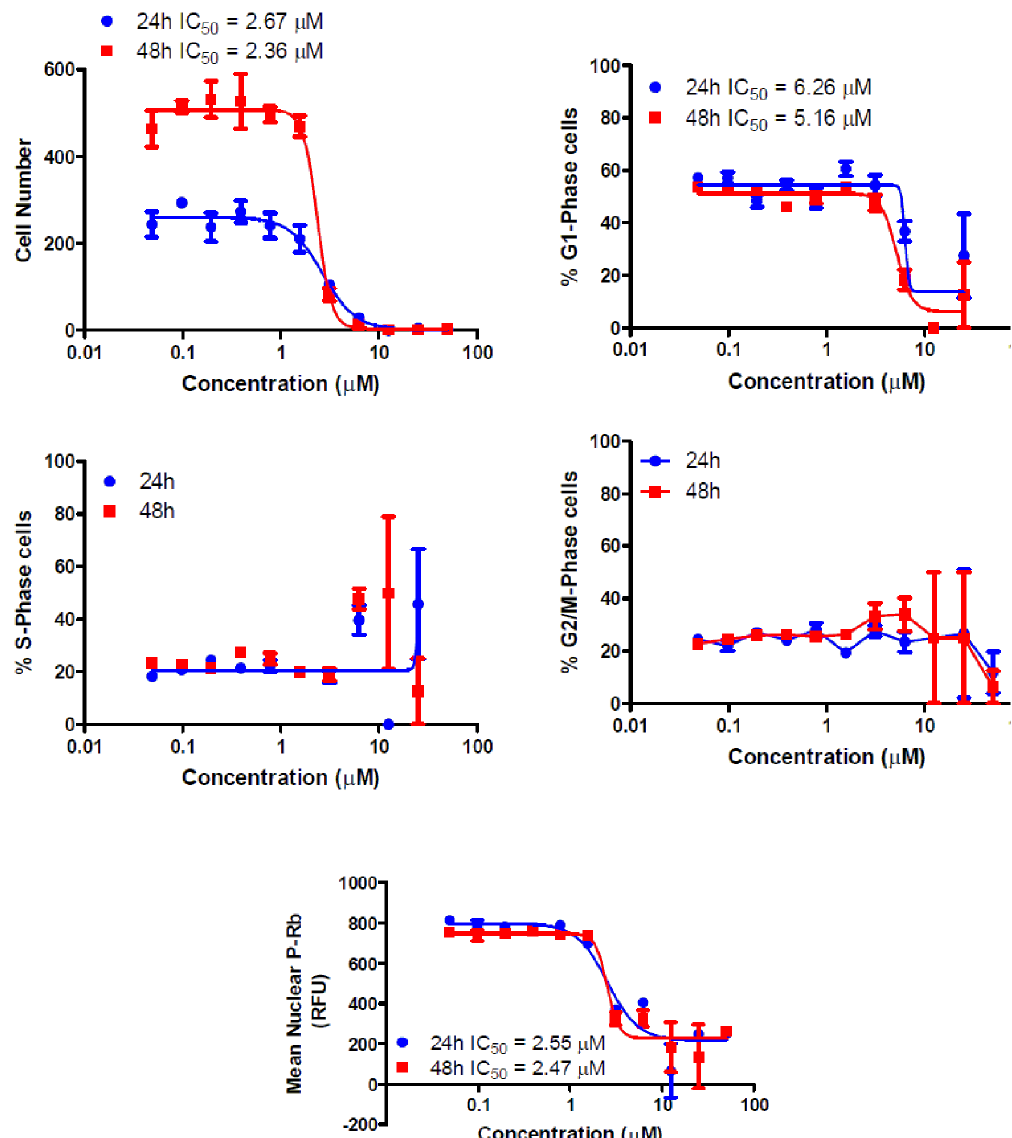
Fig 5. Dose-dependent changes in cell cycle. Distributionof cells within the cell cycle as well as total cell numbers were quantitatedby fluorescent staining of nuclearDNA with DAPI. Phosphorylated Rb protein was detected by indirectimmunofluorescencefollowedby automatedimage acquisitionand analysis. Selectivity. As an indicator of selectivity for tumor cells, compound 7e was analyzed for cell growth inhibitory activity in three non-tumorigenic cell lines.IEC-6 cells derived from rat intestine exhibit morphologic and karyotypic features of normal intestinal epithelial cells [37]. Cultures derived from human fibrocystic mammary tissue (MCF-10A) are non-tumorigenic and exhibit features of primary cultures of breast tissue, including dome formation [38].Fibro- blasts derived from embryonic tissue from mice (Swiss 3t3 fibroblasts) are both non-tumori- genic and contact inhibited [39].For comparison, the A549 human non-small cell lung cancer (NSCLC) cell line was included. This assessment of the growth inhibitory activity of the